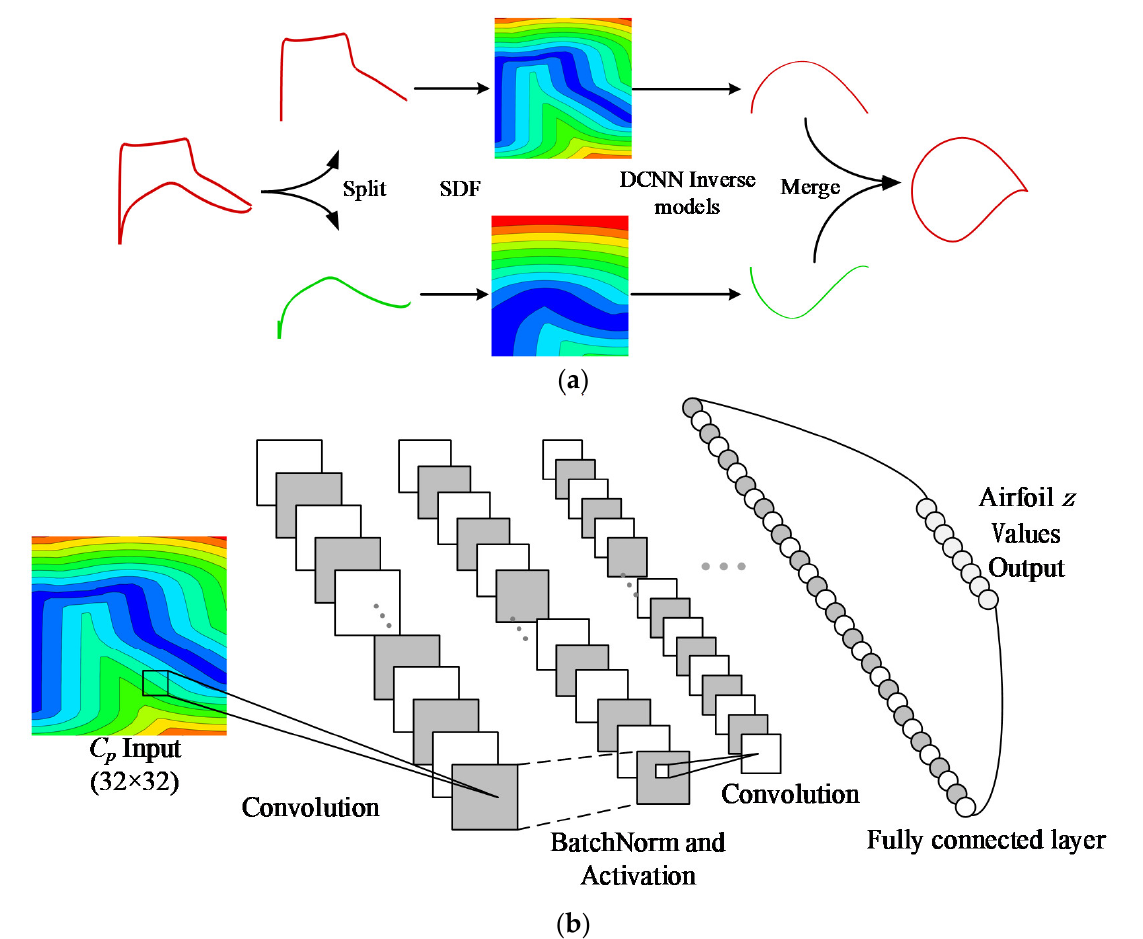
Figure 6. Architecture of DCNN to generate airfoil shape from C p distribution: ( a ) Demonstration of airfoil geometry predicted by two independent DCNN models; ( b ) DCNN model for airfoil geometry mapping.